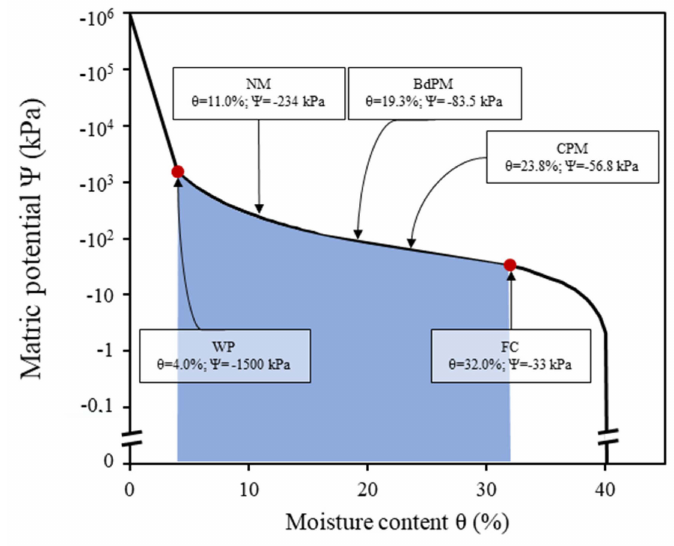
Figure 10. Water retention curve of the soil described in Chen et al. [161]. The values of the matric potential were expressed in the vertical axis in a base 10 logarithmic scale. To construct the curves, the equations collected in Saxton and Rawls [163] were used. The blue colored area represents the plants’ available water, between matric potential values of − 33 kPa (field capacity) and − 1500 kPa (wilting point). BdPM: biodegradable plastic mulch; FC: field capacity; NM: no mulch; CPM: